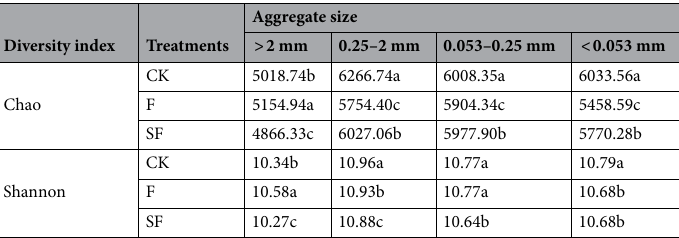
Table 3. Analysis of soil bacterial community alpha diversity at soil aggregates. Note within columns, means followed by the same letter are not significantly different according to LSD (0.05).